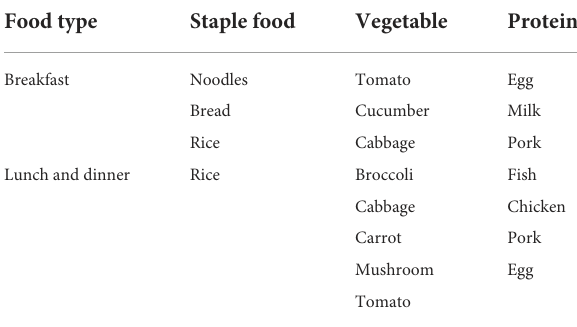
TABLE 3 Macronutrient composition of the test snacks. TABLE 4 Food types of standard